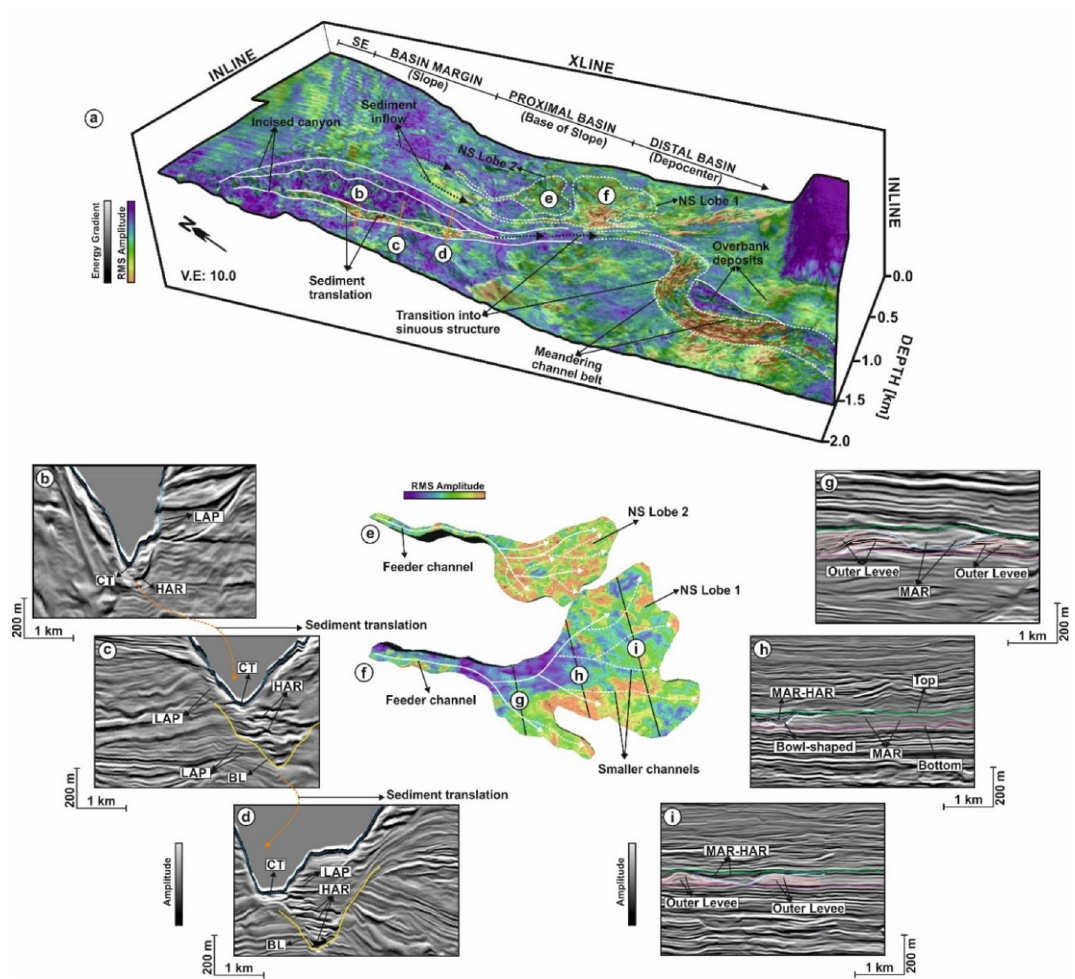
Figure 8. ( a ) TWT structure map of near-seafloor strata (~ 1200 m below the seabed top) overlain with RMS amplitude and energy gradient attributes. Different depositional elements of the turbidite system at the proximal and distal part of the basin are observed. These includes, the incised canyon, channel fills, lobes and over-bank deposits. Two distinct channel lobes namely NS Lobe 1 and NS Lobe 2 are observed on the NE part of the strata; ( b – d ) Seismic cross-sections through the channel fills below the canyon thalweg upon making transition from the basin margin (slope) to the proximal part of the basin (base of the slope). The canyon top is indicated using blue dotted line and the basal lag surface is delimited using a yellow line; ( e – i ) 3D structure of the channel lobes and seismic cross-sections crossing the lobe (NS Lobe 1 as an example). Internally the lobes are associated with smaller channels (marked using white dotted arrow) fed by the main channel source from the proximal area (marked using thick white arrow). The lobes interfinger in the distal area and are dominated by high amplitude reflections. In cross-sections, the top and bottom surface of the lobe is indicated using green and pink line and the levees are marked by cream lines. ( CT Canyon Thalweg, NS Near seafloor, LAP Lateral Accretion Package, HAR High Amplitude Reflection, BL Basal Lab, MAR Moderate Amplitude Reflection, SE Shelf Edge). (The above maps are prepared using licensed version of Corel Draw v16 and OpendTect interpretation Suite Distribution of porous, sand‑rich sediment in the Waikato Submarine Canyon. The seafloor towards the SE coast of South Island is characterized by a narrow and shallow continental shelf (Fig. 1b,d), beneath of which lies the thin continental crust of the Campbell Plateau 20 . The Waitaki Submarine Canyon acted as a transfer zone for transporting sediments from the shelf to the Bounty Trough 19 . At its lower reach (i.e., towards base of the slope) the canyon pathways connect to the North Bounty channel (Fig. 1b), ultimately merging with the south and central channel to form the Bounty Channel at a distance approximately 200 km seawards from the shelf edge. Our structurally-conditioned 3D seismic data show that continuous transport of sediment through shelf- incised submarine canyons resulted in the deposition of large volumes of turbidites further downslope in the form of channel overbanks, meandering channel belts, channel-fill deposits and sediment lobes in the NE part of the study area (Fig. 8). The SW region preserves the sinuous channel of the Waitaki Submarine Canyon and overbank deposits (Fig. 8). These basin fill deposits form the key elements of turbidite systems associated with